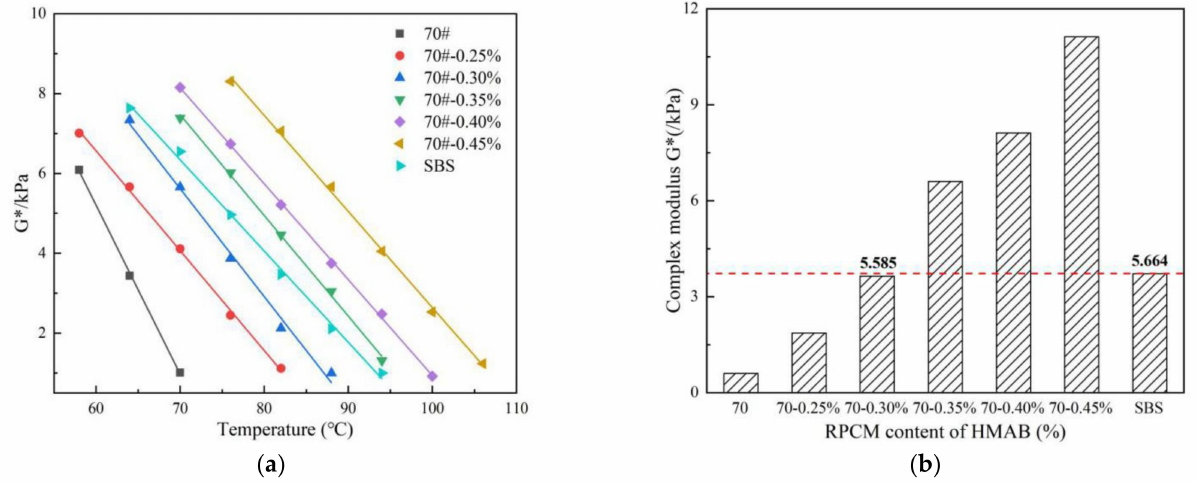
Figure 2. G*-temperature results at: ( a ) different RPCM contents, and, ( b ) 70 ◦